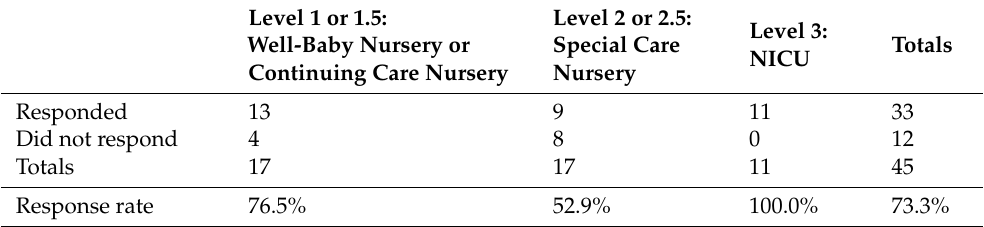
Table 2. Contingency table of response rates against maximum level of care as defined by the Code of Massachusetts Regulations (CMR).